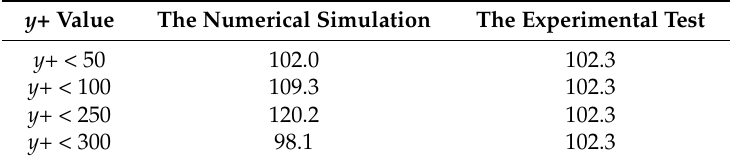
Table 1. The resistance comparison between the numerical calculation and the experimental test.